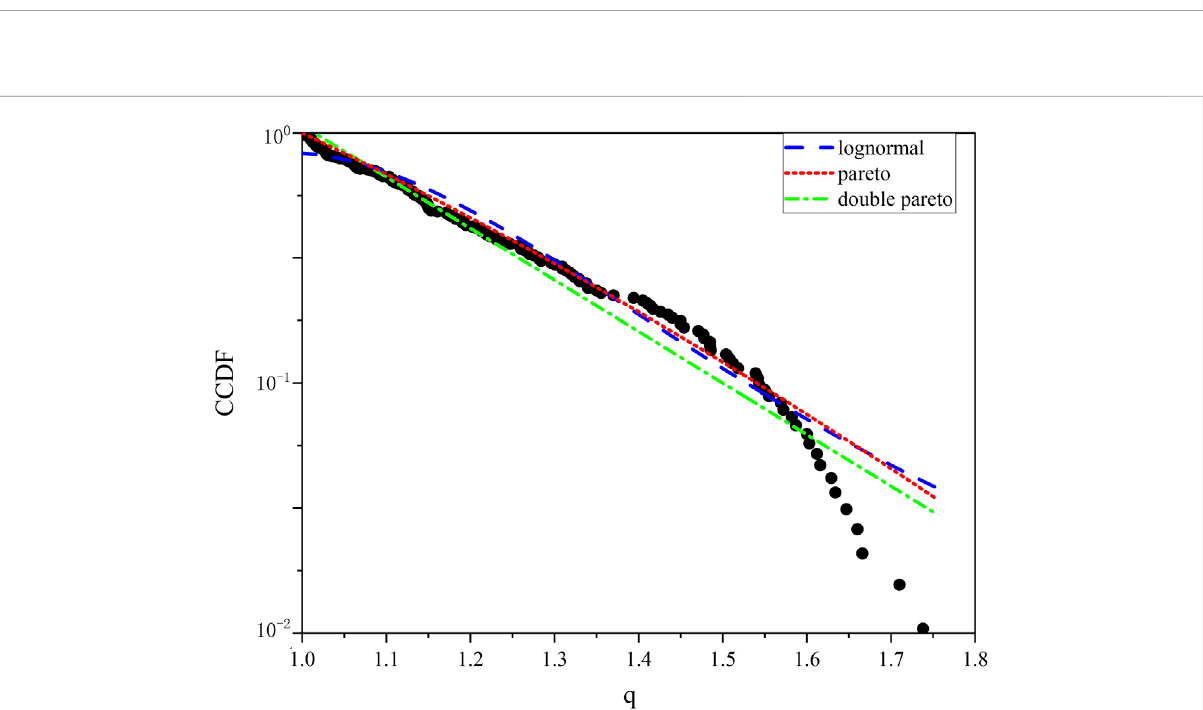
FIGURE 8 In the log-log fi gure of CCDF and q value, the curve presents Pareto distribution in the tails, and lognormal distribution in the middle.